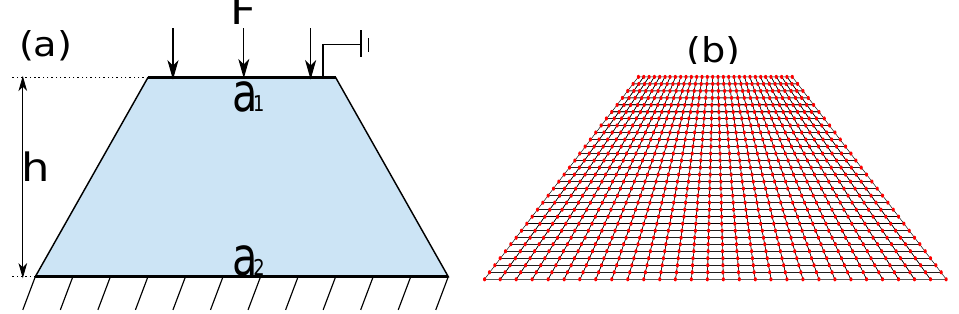
Figure 6. Schematic illustration of: ( a ) the pyramid case and its boundary condition; ( b ) MLS discretization with the red solid point representing the nodes.